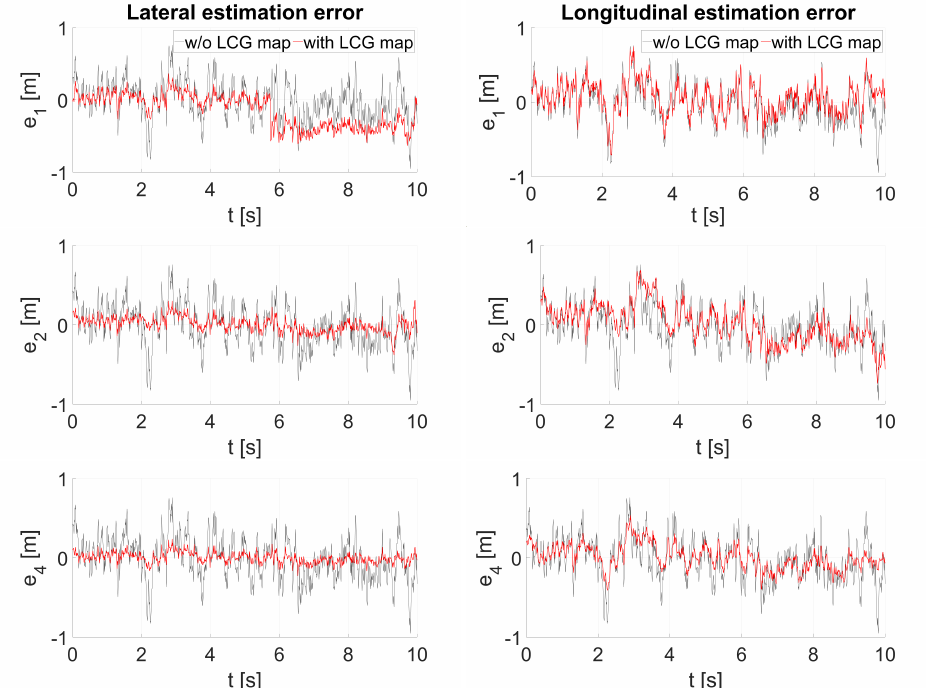
Figure 8. Time evolution of the lateral ( left column ) and longitudinal ( right column ) estimation errors for different ultrasound sensor configurations. The subscript in the vertical axis label, i.e., e i , with i = 1,2,4, identifies the number of ultrasound sensors equipped onboard. In this figure, the estimation error obtained using only GPS and IMU (black lines) is compared with the one obtained including data from ultrasound sensors and LCG maps (red line).